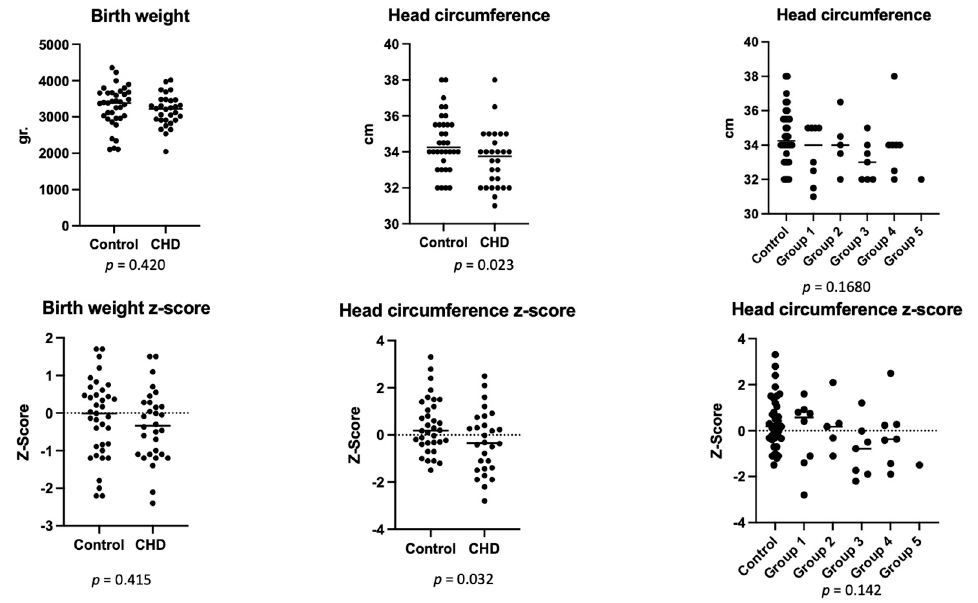
Figure 3. Neonatal Figure 3. Neonatal biometrics.